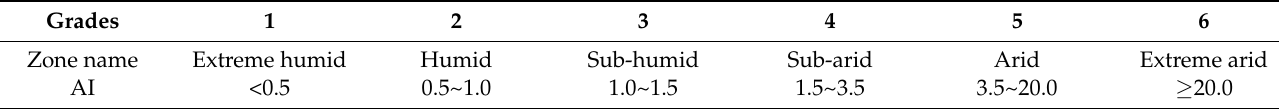
Table 2. The grades of dry-wet climate